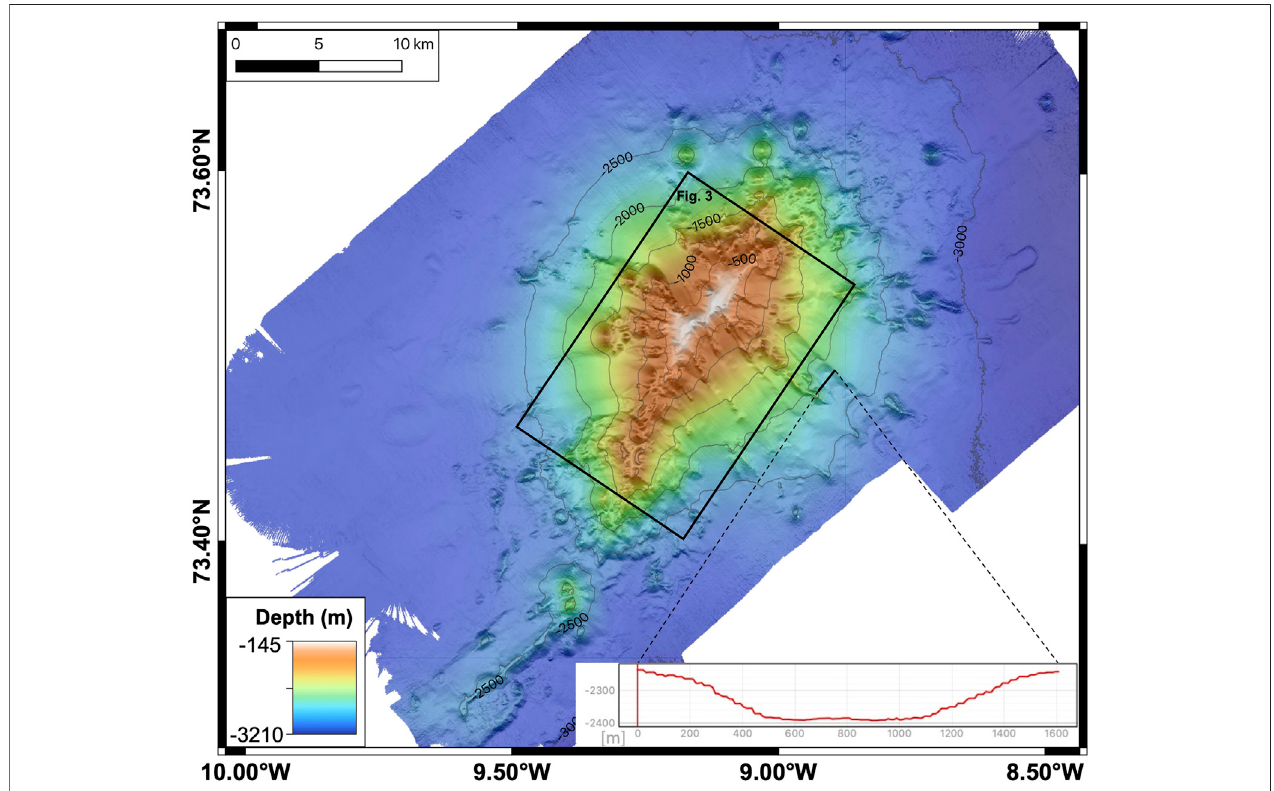
FIGURE 2 | Detailed bathymetric map of Vesteris Seamount from EM122 multibeam sonar data. The DEM has a resolution of 25 m. The inset shows a cross section of a U-shaped channel. Box shows area of Figure 3 .